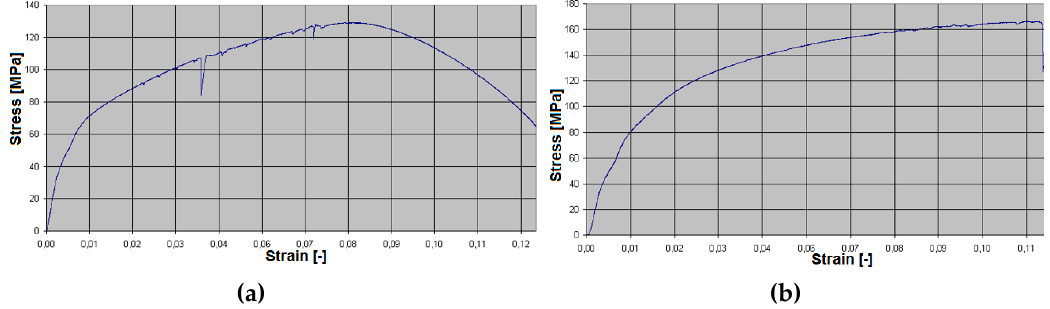
Figure 9. Beta-geometry of the weld surface for evaluation of fatigue characteristics.